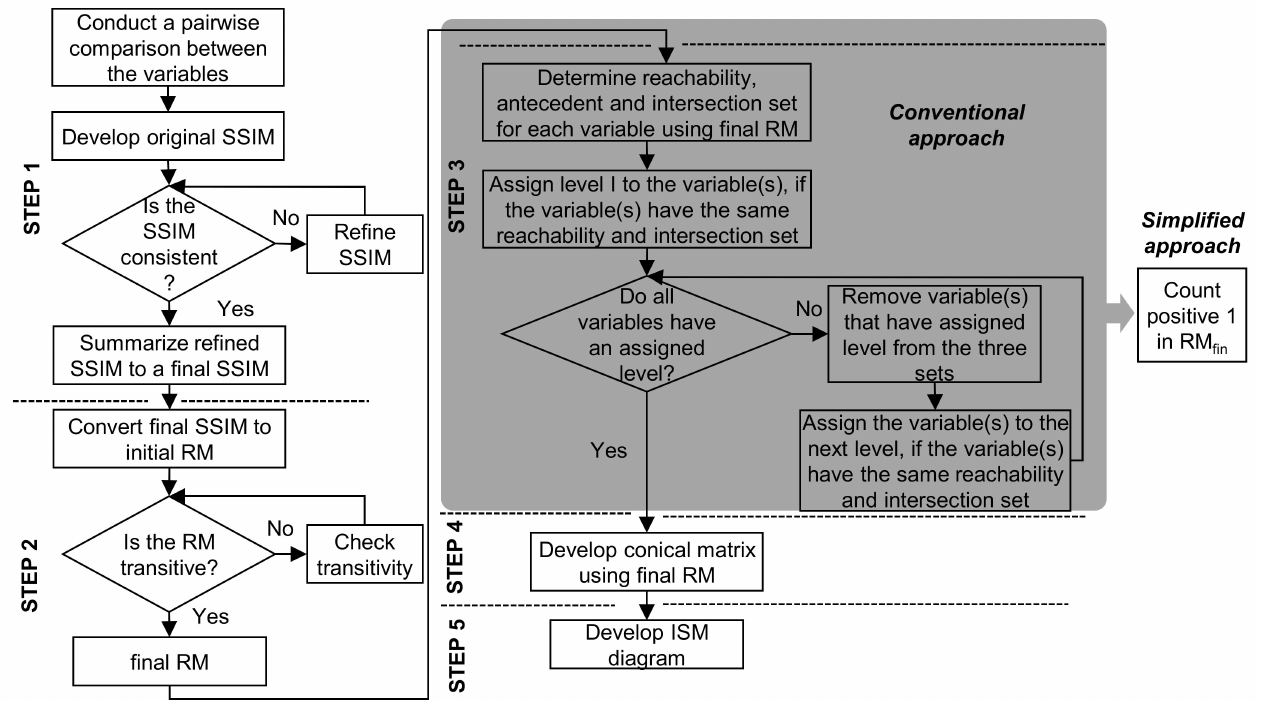
Figure 1. Flow chart of the ISM method with the simplified